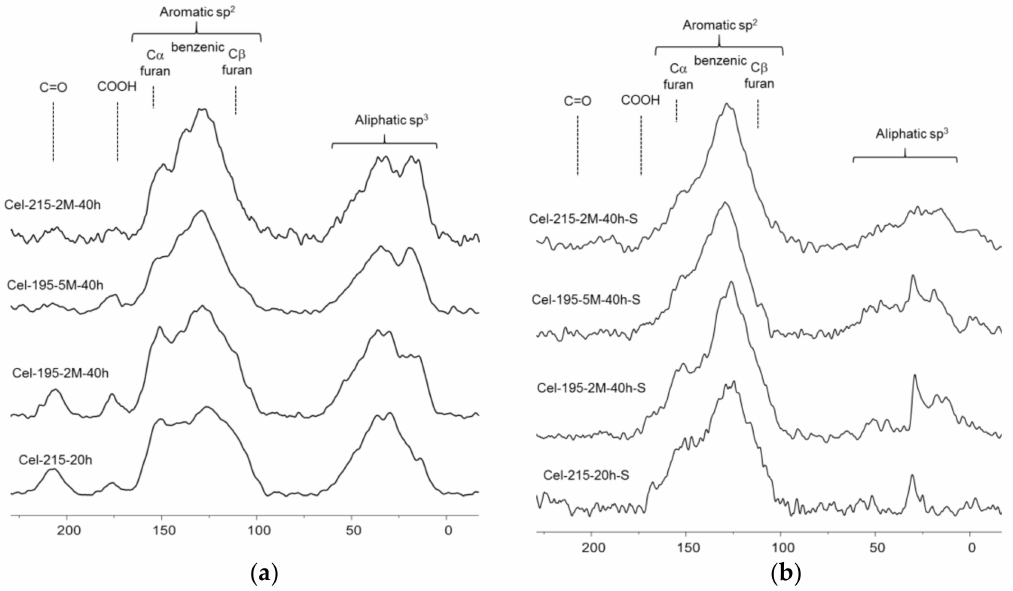
Figure 5. 13 C-CP-MAS-RMN spectra of: ( a ) HTC (samples 4, 7, 8, 9); ( b ) SHTC (samples 4-S, 7-S, 8-S,